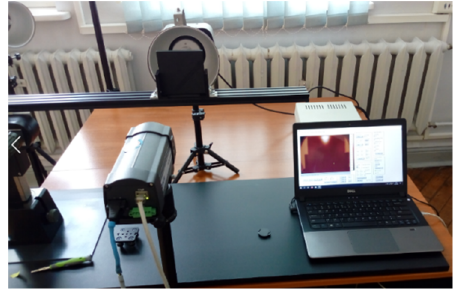
Figure 3. Photo of the experimental setup.